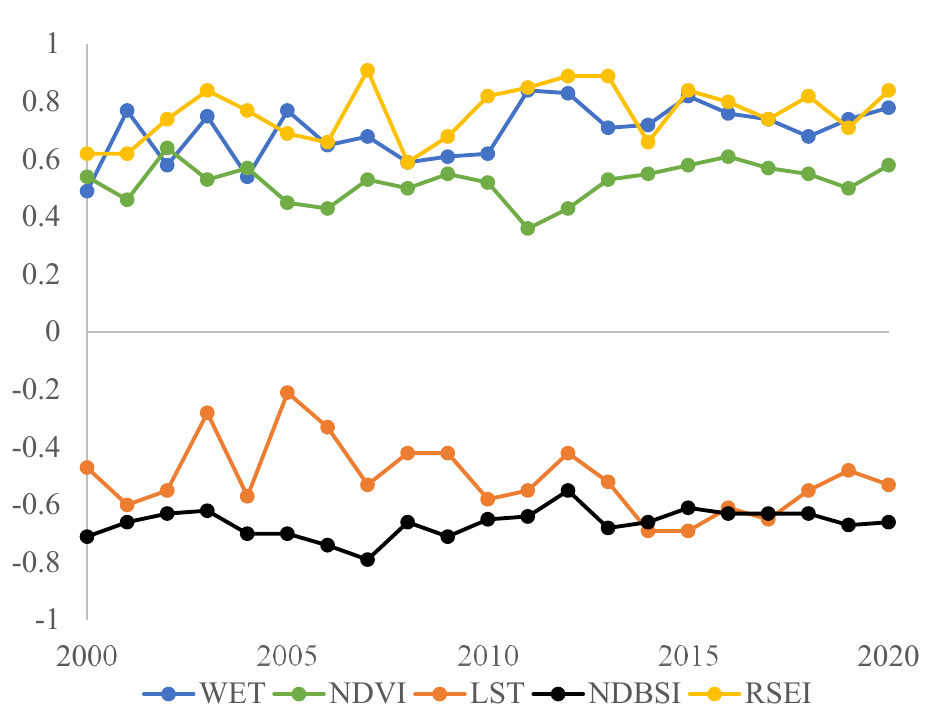
Figure 4. 2000 − 2020 RSEI and four component size scatter plots.